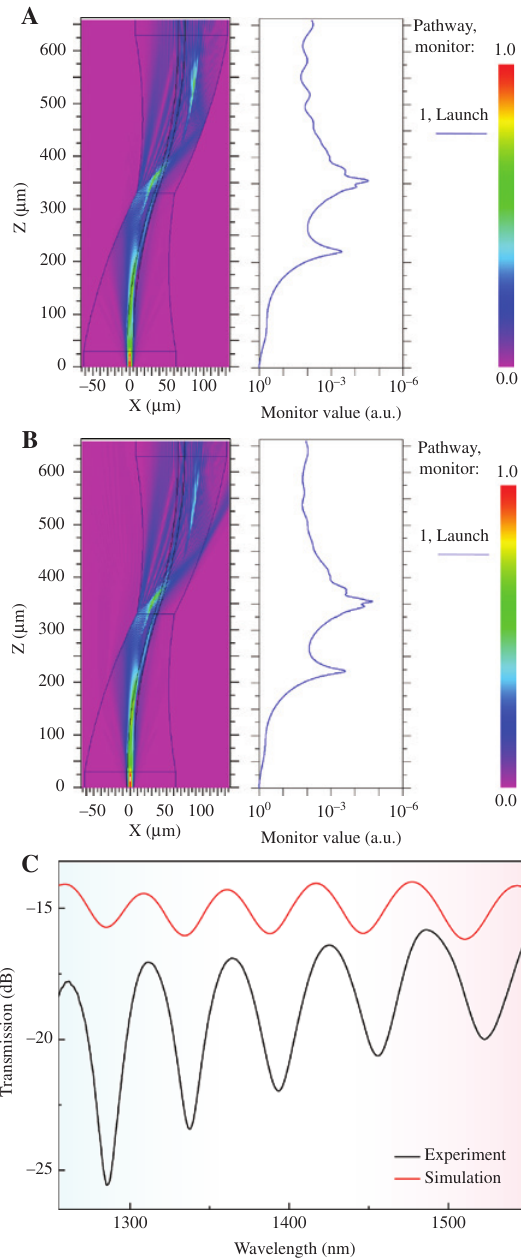
Figure 3: Simulation results of S-taper fibre. The simulated light propagation of the S-taper fibre in air (A) and in biological reagent (B), respectively. (C) The simulated as well as experimentally acquired transmission spectra of the proposed S-tapered fibre in air.